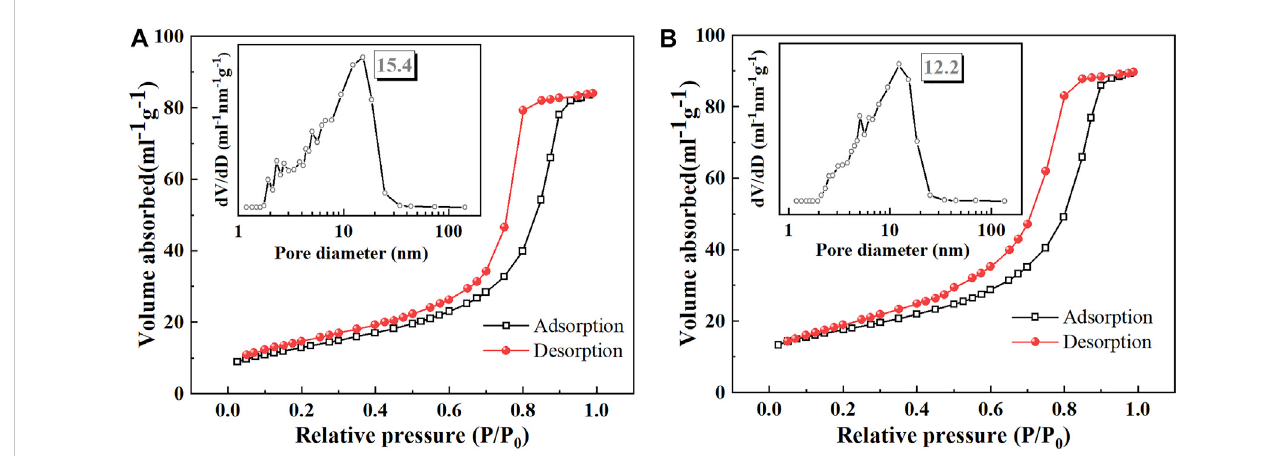
FIGURE 3 N 2 adsorption-desorption isothermal curves of Ce-N-TiO 2 (A) and CeNT@Oys (B) . (inset: The pore size distribution curve of (A) Ce-N-TiO 2 and (B) CeNT@Oys).